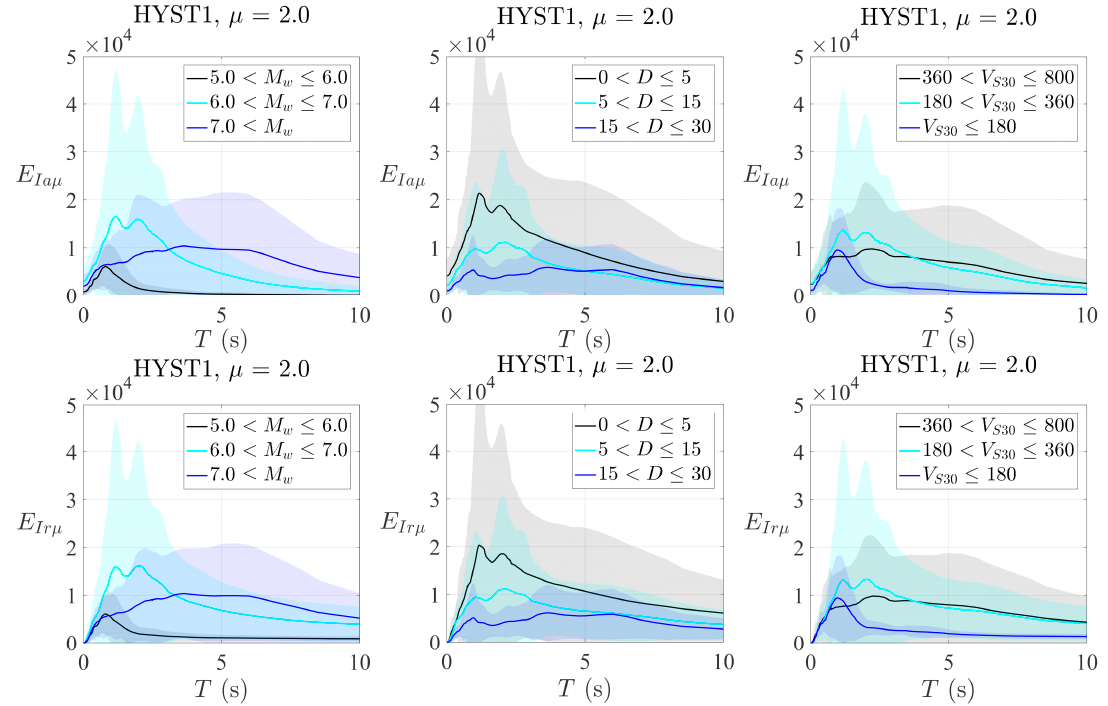
Figure 3. Spectra of the absolute E Ia µ and relative E Ir µ input energy for the hysteretic model HYST1 and ductility level µ equal to 2 considering di ff erent subsets of seismic records (filled area: envelope of the spectra; solid line: mean spectrum).